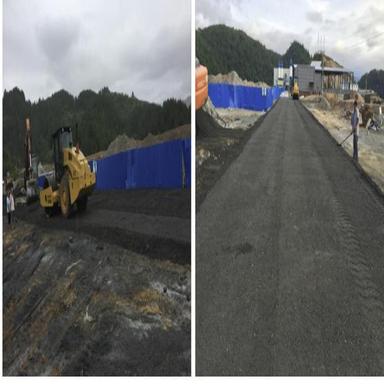
Pictures of field tests.